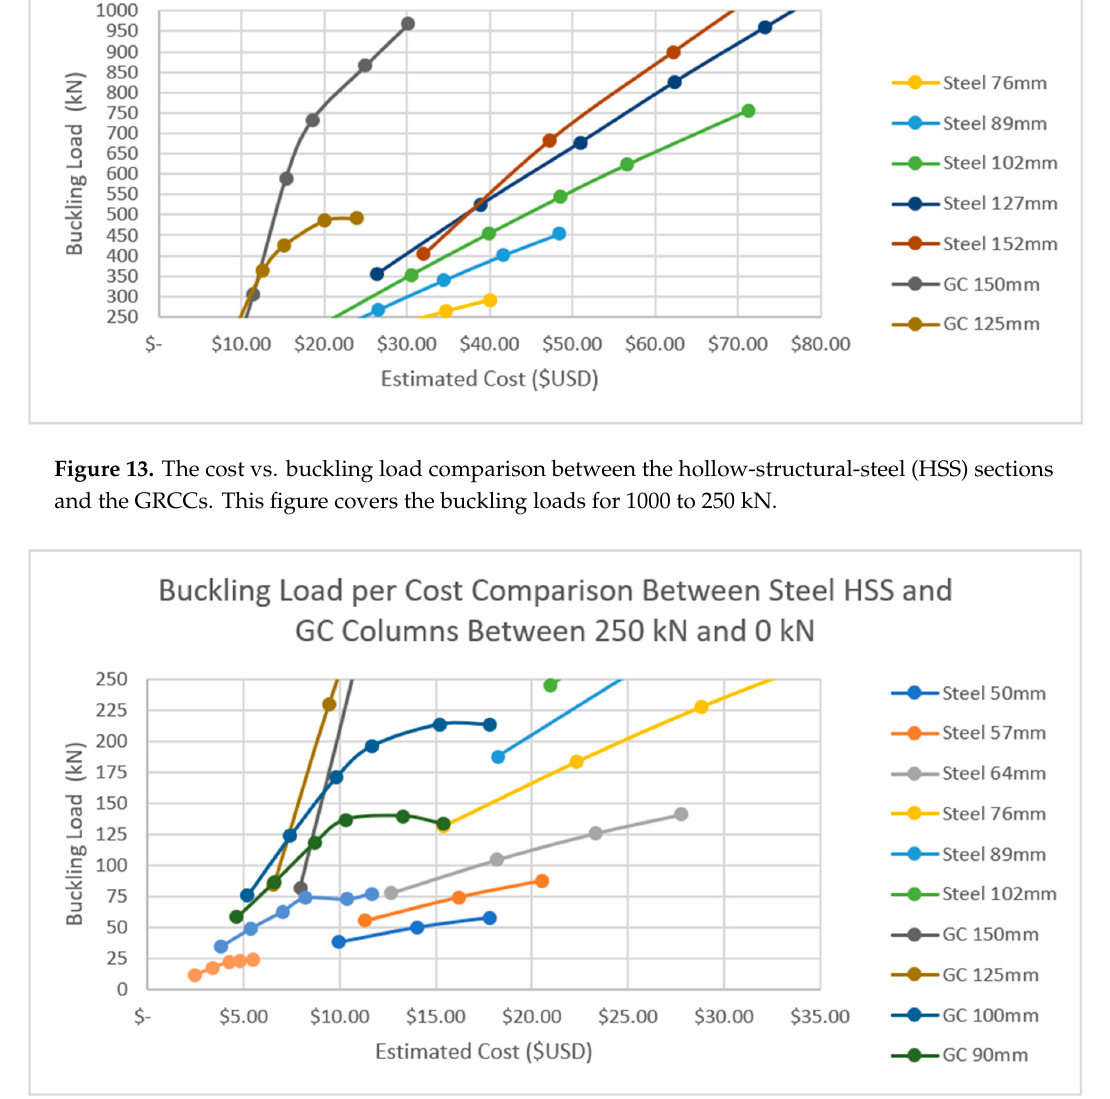
Figure 14. The cost vs. buckling load comparison between the hollow-structural-steel (HSS) sections and the GRCCs. This figure covers the buckling loads for 250 to 0 kN.